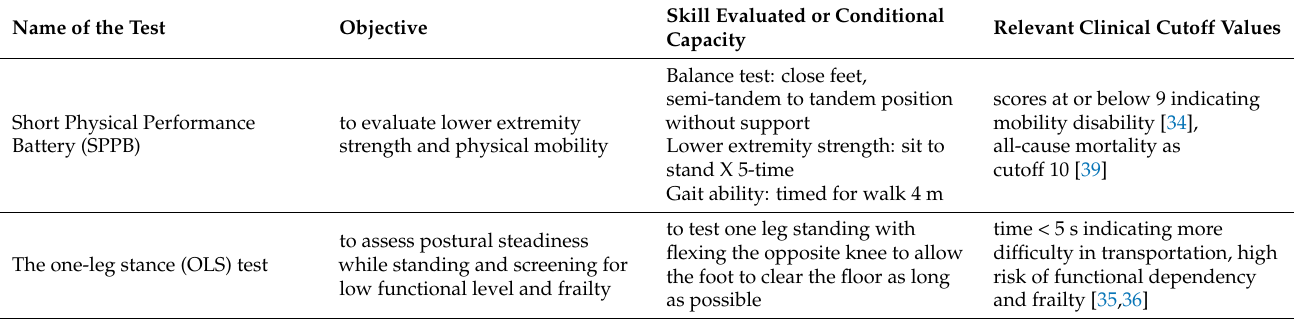
Table 1. Name of all outcome tests, their objectives, skill evaluated or conditional capacity, and relevant clinical cutoff